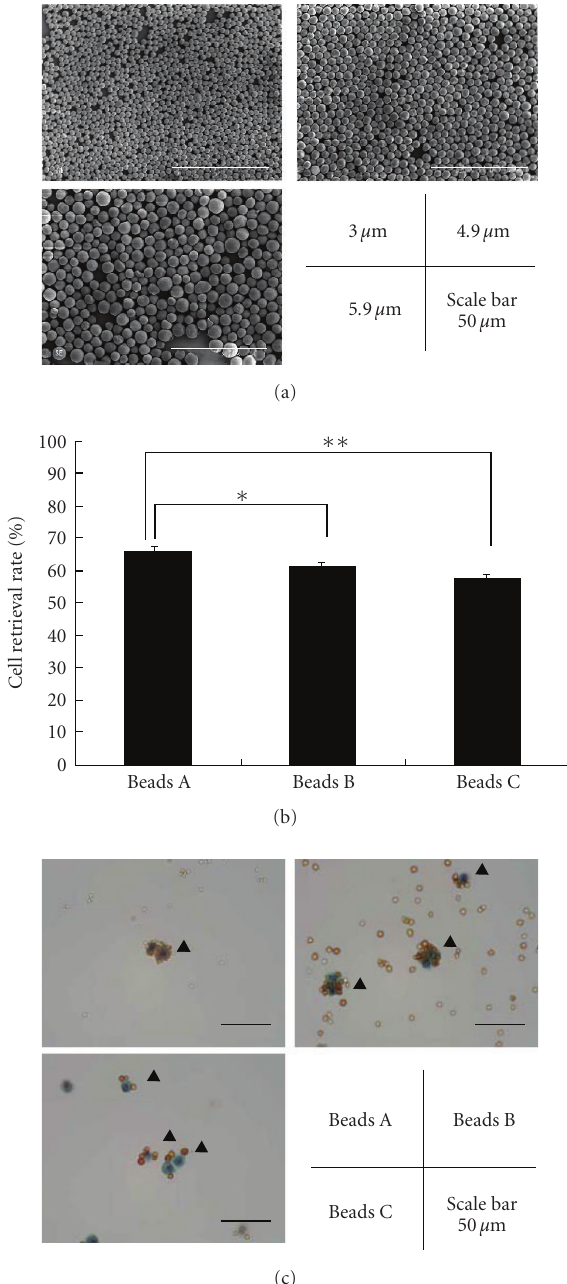
Figure 1: Simulation to evaluate the recovery rates of colonocytes using several sizes of beads. (a) Electron microscopy images show 3 di ff erent sizes of magnetic beads prepared by us. The sizes are 3.0, 4.9, and 5.9 μ m. Scale bar, 50 μ m. (b) Comparison of cell recovery rates. The cell recovery rates using beads A (smallest, 3.0 μ m), beads B (medium, 4.9 μ m), and beads C (largest, 5.9 μ m) are 65.9 ± 1.37 (%, mean ± SD), 61.1 ± 0.98, and 57.1 ± 0.75, respectively. The columns show the cell retrieval rates and the bars show the standard deviations. Significant di ff erences are showed by an asterisk ( ∗ , P = .0001) or a double asterisk ( ∗∗ , P < .0001). (c) Papanicolaou staining of HT-29 cells captured using immunomagnetic beads. The arrowheads show the cell-bead complexes. The beads A have adhered to the HT-29 cells with the highest densely. Scale bar, 50 μ